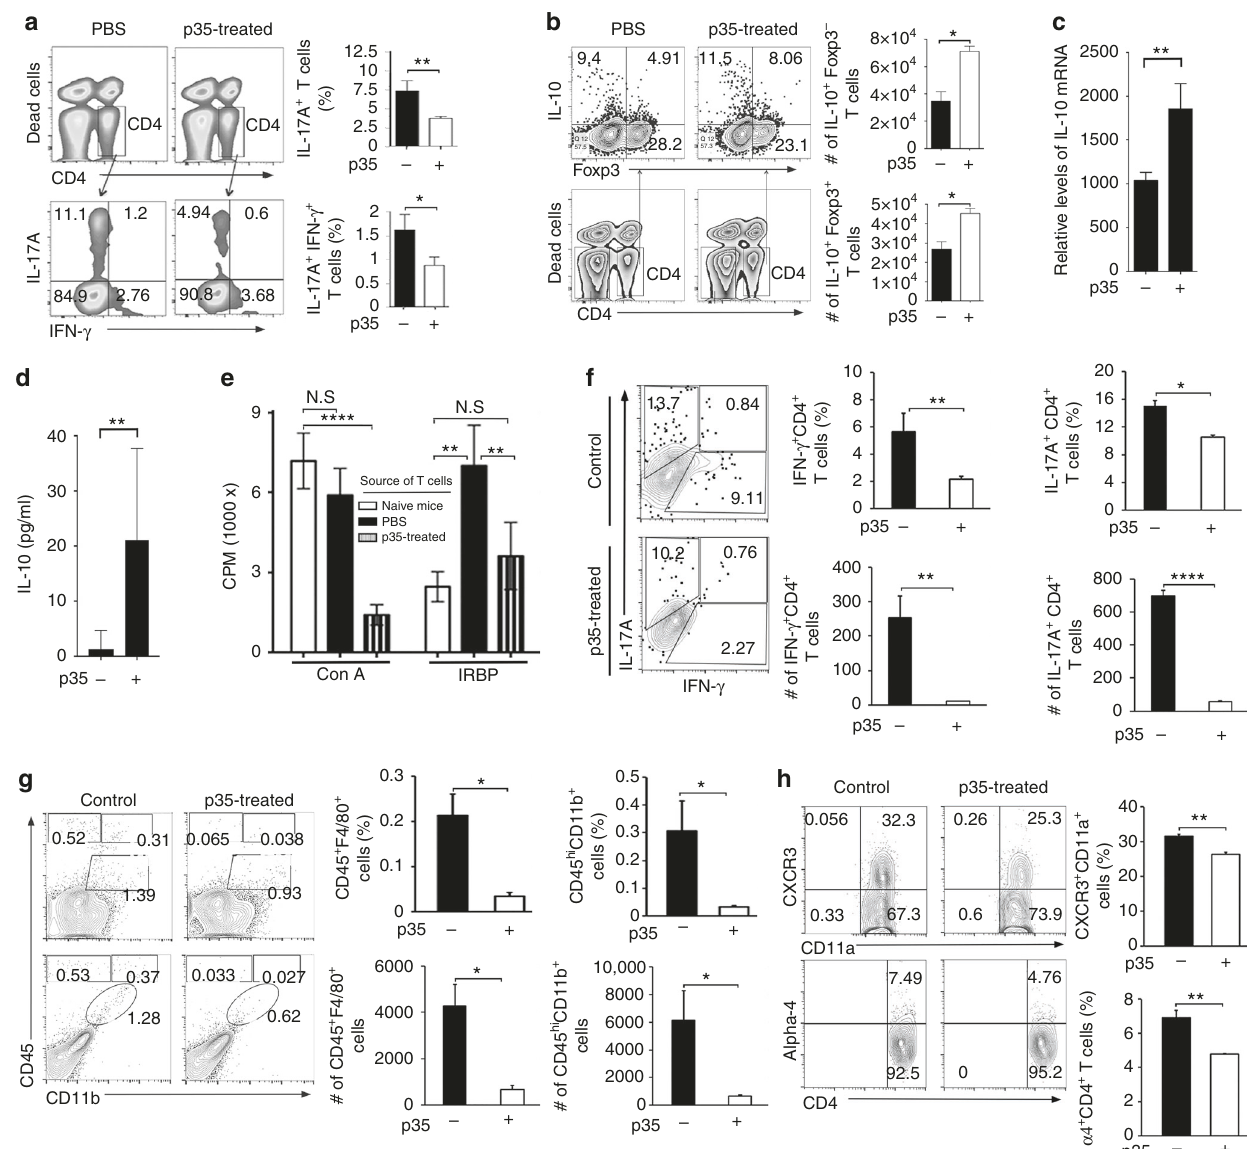
Fig. 4 p35 inhibited the expansion of Th17 cells and reduced traf fi cking of in fl ammatory cells into the retina during EAU. a , b Intracellular cytokine analysis of IL-17-, IL-10-, Foxp3- or IFN- γ -expressing CD4 + T cells in draining LNs on day 21 after induction of EAU. The cells were fi rst stain with viability dye eFluor 450 (Invitrogen) to exclude dead cells and then subjected CD4 cell surface marker staining. The intracellular cytokine/protein staining fi nally was performed following cell permeabilization and cells were analyzed for IL-17, IFN- γ , IL-10, and/or Foxp3 expression a , b . Plots were gated on CD4 + T cells and numbers in quadrants indicate percent of CD4 + T cells expressing IL-10, IL-17, and/or IFN- γ . c cDNA was prepared from LN CD4 + T cells and analyzed by RT-PCR. d Serum from untreated or p35-treated EAU mice were analyzed by ELISA. e Draining LN cells from untreated or p35-treated EAU mice were re-stimulated in vitro with Con A or IRBP for 3 days and assessed by Thymidine incorporation assay. f – h Retinae of mice that were either untreated or treated with p35 were isolated 21 days after induction of EAU, digested with collagenase and analyzed by FACS. Graphs indicate relative abundance of f IFN- γ + and IL-17 + CD4 + T cells; g CD45 + CD11b + and/or CD45 + F4/80 + myeloid cells; h CXCR3 + CD11a + or α 4 + CD4 + T cells. Results represent at least three independent experiments and were analyzed using Student ’ s t -test (two-tailed). Data are mean ± SEM. (* P < 0.05; ** P < 0.01; *** P < 0.001; **** P <